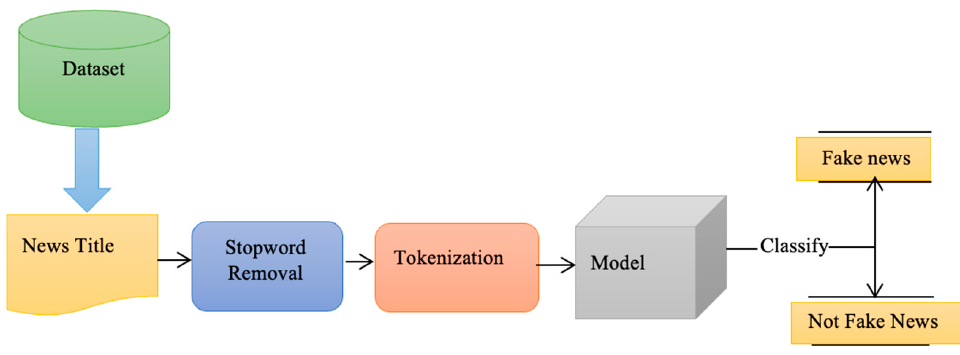
Figure 1. General model for the classification of fake news over social media.